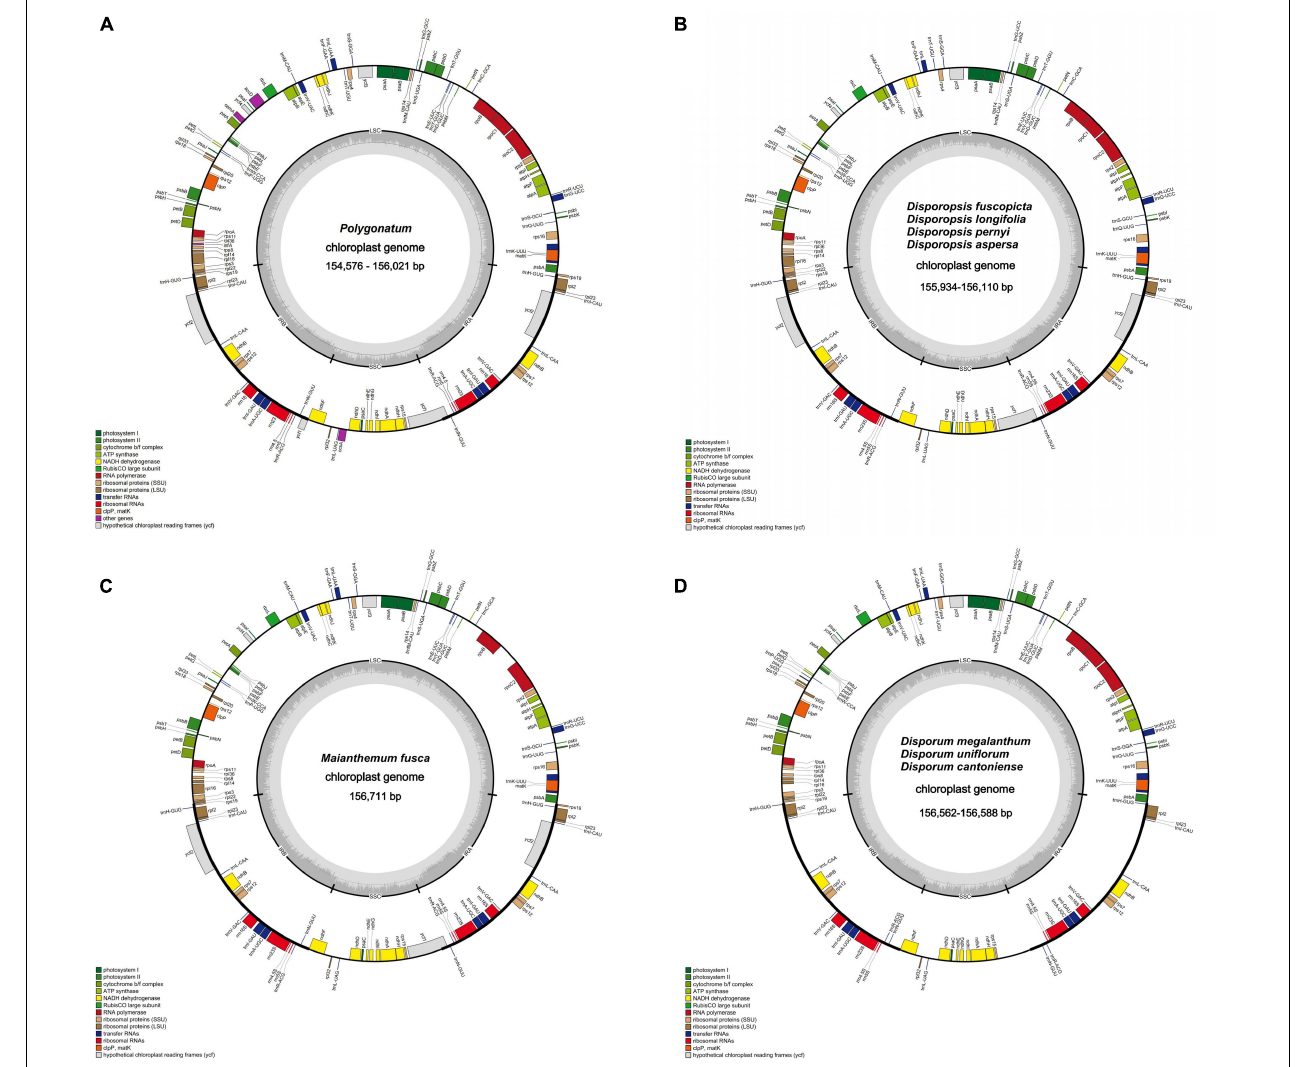
FIGURE 1 | Chloroplast genome map: (A) Polygonatum , (B) Disporopsis , (C) Maianthemum , (D) Disporum. Genes inside and outside the circle are transcribed in a clockwise and counter-clockwise direction.